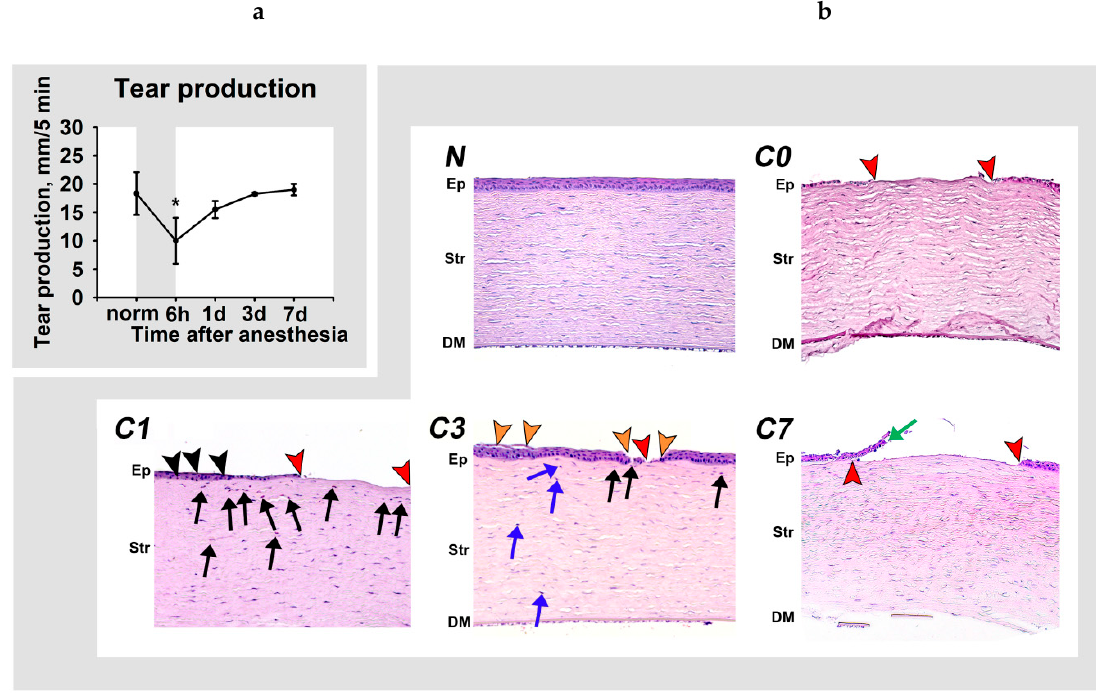
Figure 1. Dynamic changes in tear secretion and corneal morphology in general anesthesia-induced DES. ( a ) The results of standardized Schirmer’s tests performed in animals at 6th hour, 1st day, 3rd day or 7th day after their exposure to 6-h general anesthesia. ∗ p < 0.05 compared with the values measured in the control group. ( b ) Representative microscopic images of hematoxylin and eosin-stained cross-sections of the corneas obtained at 6th hour (C0), 1st day (C1), 3rd day (C3) and 7th day (C7) after exposure of the animals to general anesthesia. The image of the normal cornea is also presented (N). Stromal denudation (complete absence of the corneal epithelium) areas (red arrowheads), loci of desquamation / destruction of the epithelial layer (orange arrowheads), and sites of reepithelialization (green arrows; the detachment of the new epithelium from the stroma represents an artifact stemmed from histological processing) are indicated. The inflammatory changes include granulocytic infiltration of the corneal epithelium (intraepithelial granulocytes; black arrowheads) and stroma (black arrows), and postinflammatory signs of regeneration (activation of stromal keratocytes) at the ex-sites of the infiltration (blue arrows). Ep: epithelium; Str: stroma; DM: Descemet’s membrane and endothelium. Hematoxylin and eosin staining, magnification 200 × . The central areas of the cornea are presented. Gaps, cracks and folds of preparations are of an artificial origin.